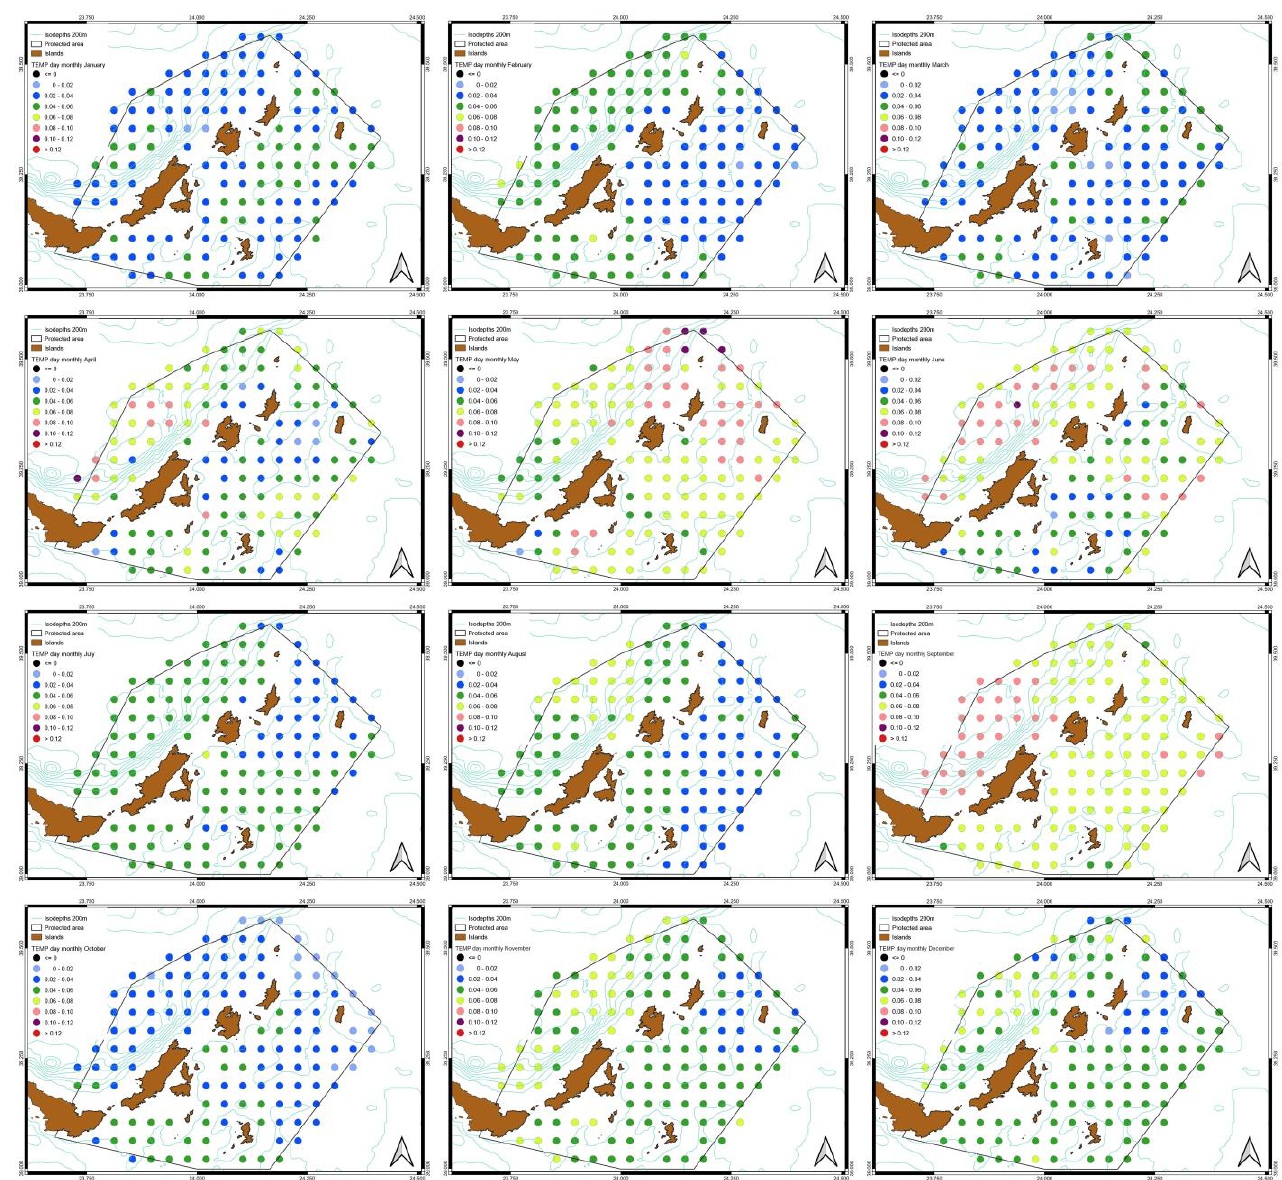
Figure 8. Monthly spatial variation of slopes from SST daytime values. All the months show a positive trend.